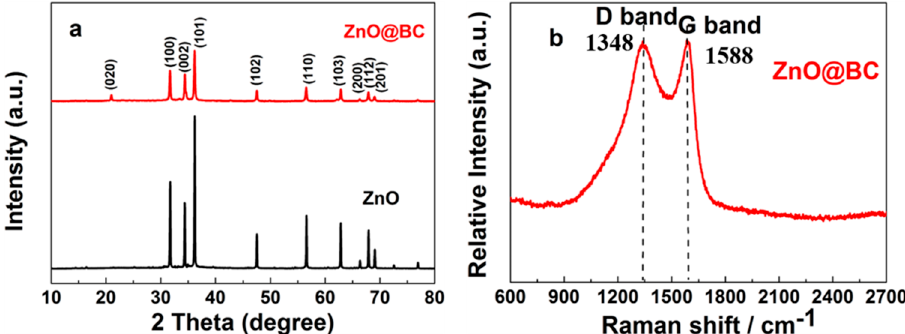
Figure 3. ( a ) XRD patterns of ZnO@BC; ( b ) Raman spectra of ZnO@BC.